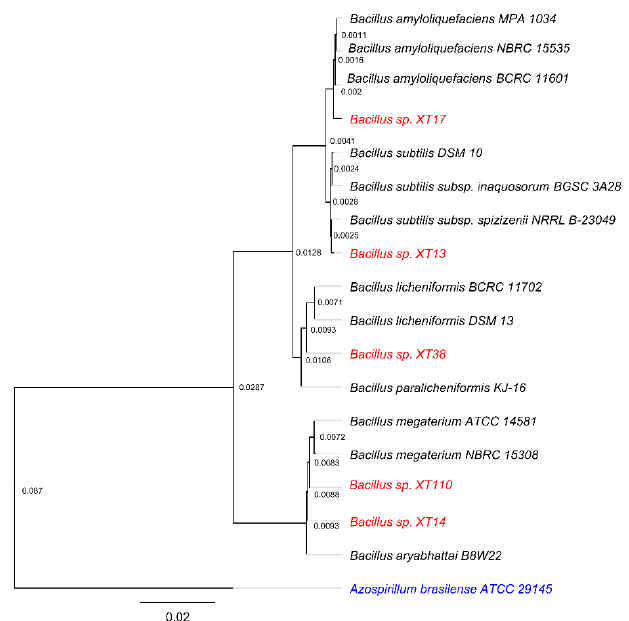
Figure 1. Phylogenetic dendrogram based on a comparison of the 16S rRNA gene sequence of strains XT13, XT14, XT17, XT38, and XT110, using type strains of the genera in the order Bacillales . The tree was created using the Neighbor-Joining method and the Tamura-Nei genetic distance model. The strains used in this study are indicated in red. The Azospirillum brasilense ATCC 29145 sequence was used as root for the tree and is indicated in blue. Scale bar, 0.2 nucleotide substitution per 10